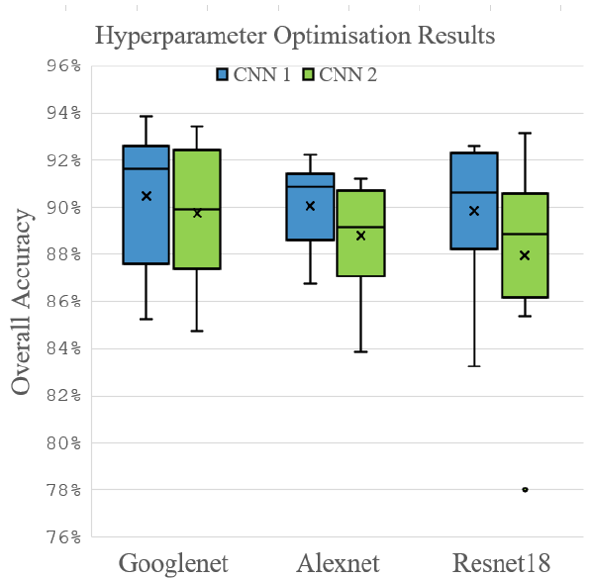
Figure 4. Results of the grid search to optimise the hyper-parameters for the three networks.